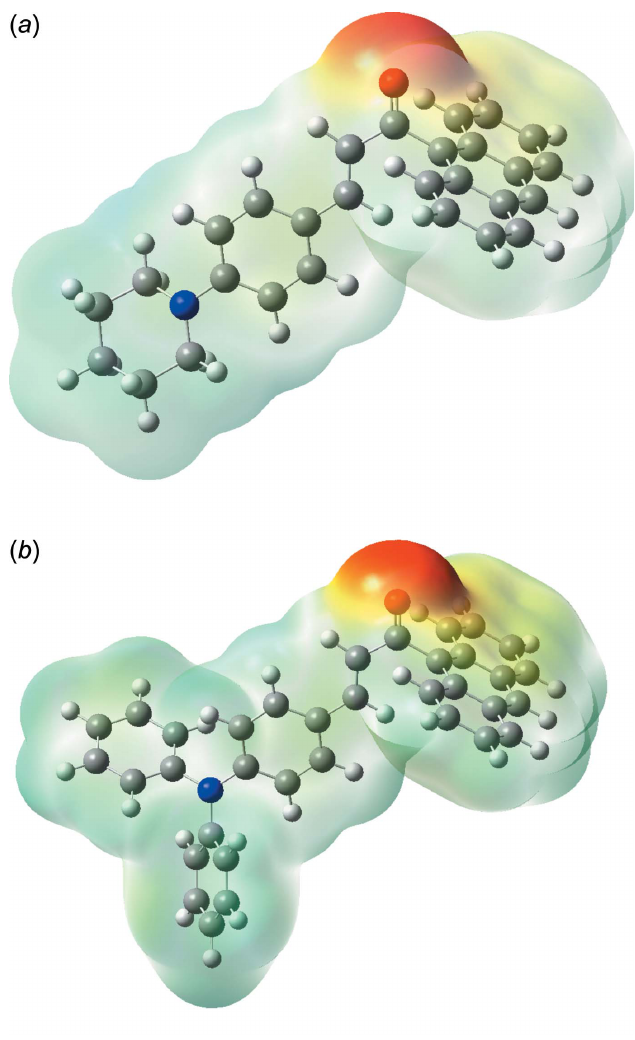
Figure 8 The total electron density three-dimensional surface mapped for ( a ) compound (I) and ( b ) compound (II) with the electrostatic potential calculated at the B3LYP/6–311 G++ (d,p)